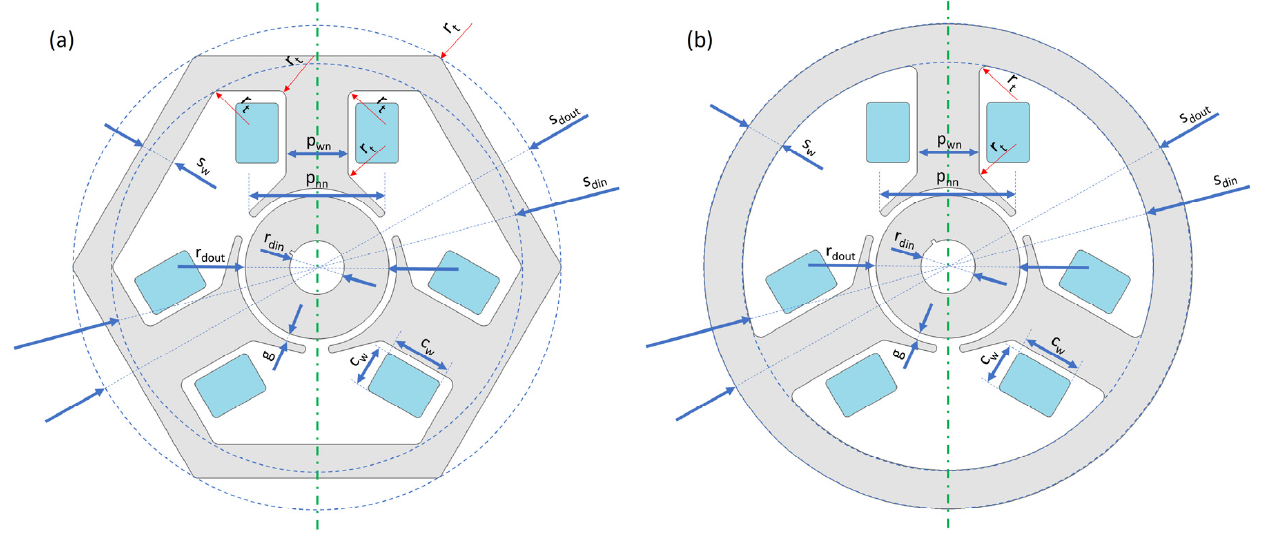
Figure 10. Analogies between the reference model, ( a ) B3.b, and the model ( b ) A3.a. For models from the _.b group, width p wn = p nn .